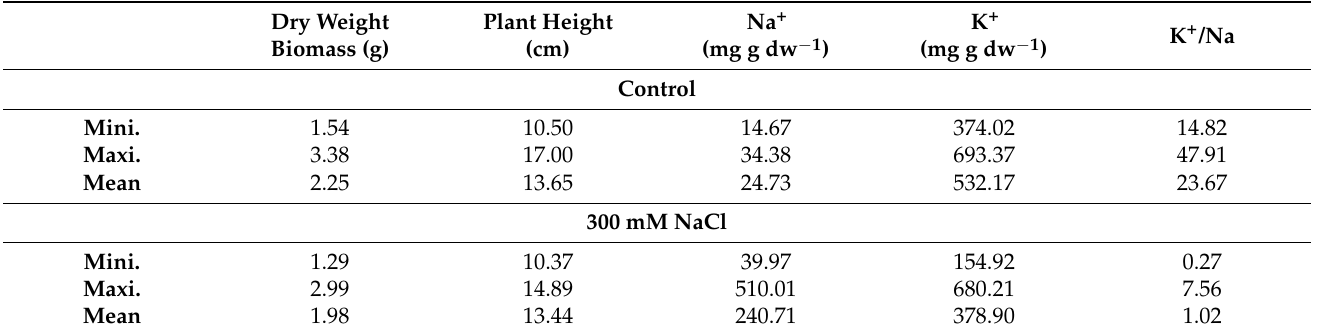
Figure 2. A regression analysis between salinity tolerance and Na + concentrations in 40 Ae. tauschii populations were collected from different parts of China. The circle indicates the populations with salinity tolerance, which showed the lowest sodium concentration and maximum dry biomass. The fitted linear regression is R 2 = 0.62. Table 2. Mean values of physiological traits under control and salinity stress conditions.